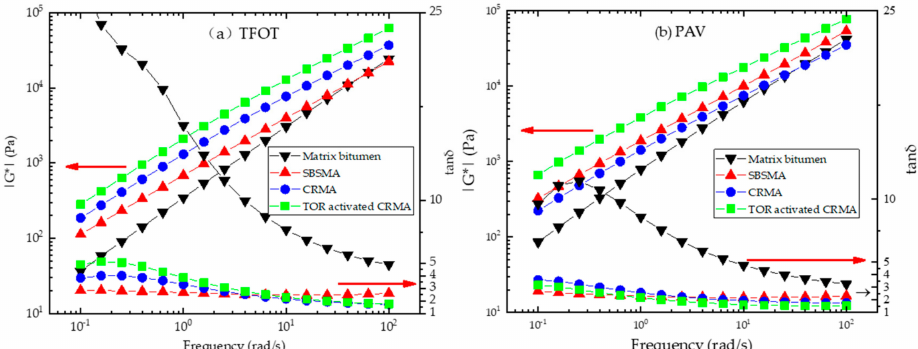
Figure 8. Changes in phase angle and shear modulus of asphalt binders in pace with frequency after ( a ) thin film oven test (TFOT) and ( b ) pressure aging vessel (PAV) aging at 60 ◦ C.